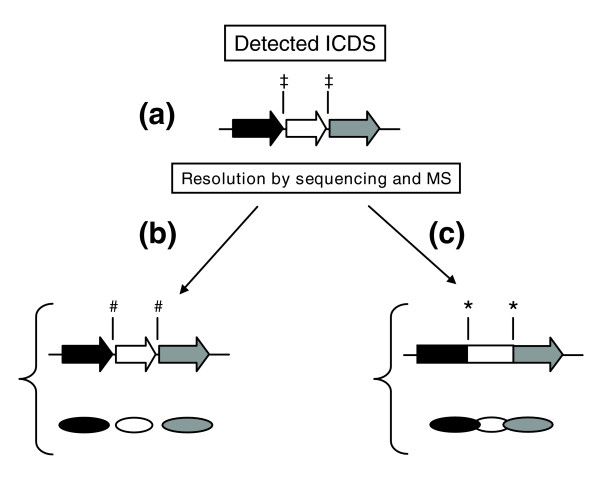
Scheme for ICDS detection and resolution strategy. (a) ICDSs are detected within the genome by in silico analysis. The double daggers (‡) indicate the regions containing the identified frameshift. Upon resolution by sequencing and mass spectrometry analysis, the ICDSs can be classified as (b) true frameshifts or (c) sequencing errors. The hash symbol (#) indicates the region of the ORF containing the frameshift. The asterisks (*) indicate sites of corrected sequencing errors resulting in the reconstitution of a full-length ORF. The ORFs are depicted with arrows. The ORF may or may not be in the same frame. Proteins are represented by ellipses.